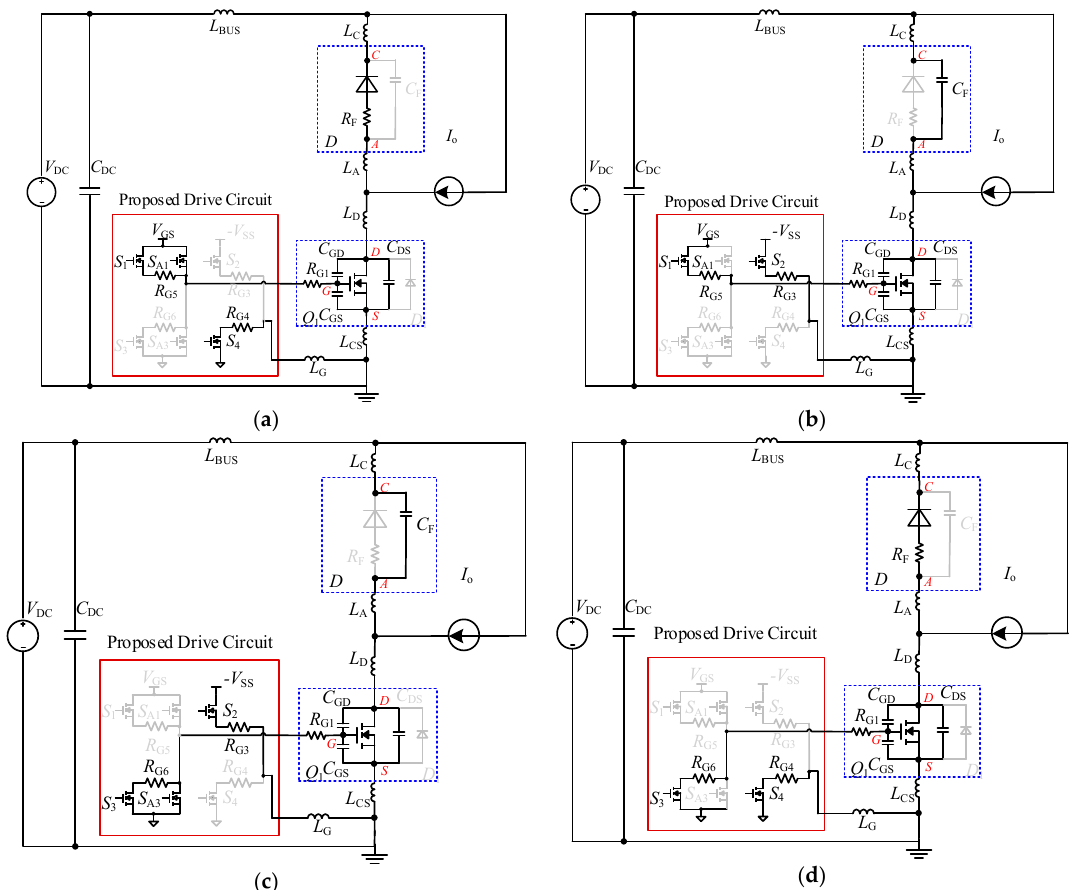
Figure 6. Equivalent circuit of each working mode: ( a ) Mode 1, ( b ) Mode 2, ( c ) Mode 3, and ( d ) Mode 4.